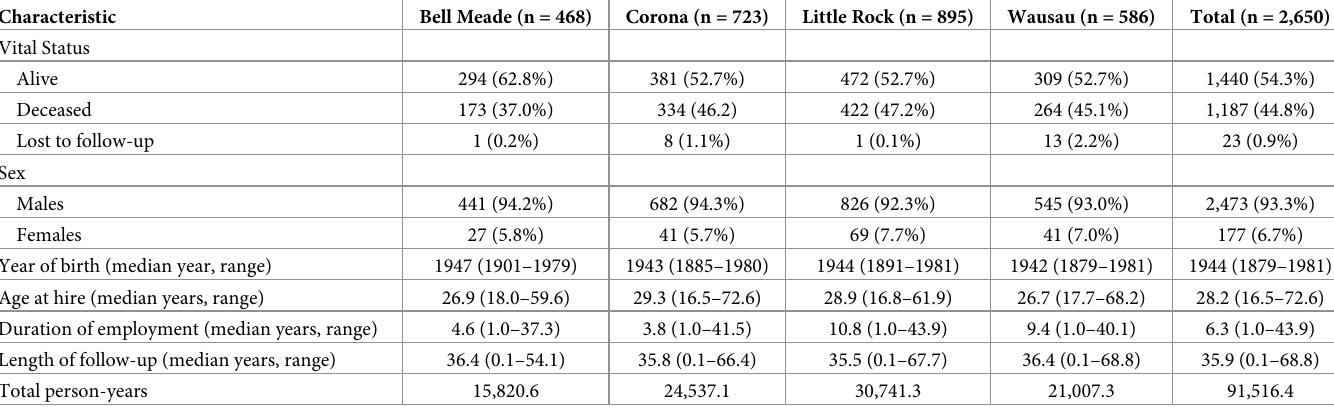
Table 1. Demographic distribution and vital status,